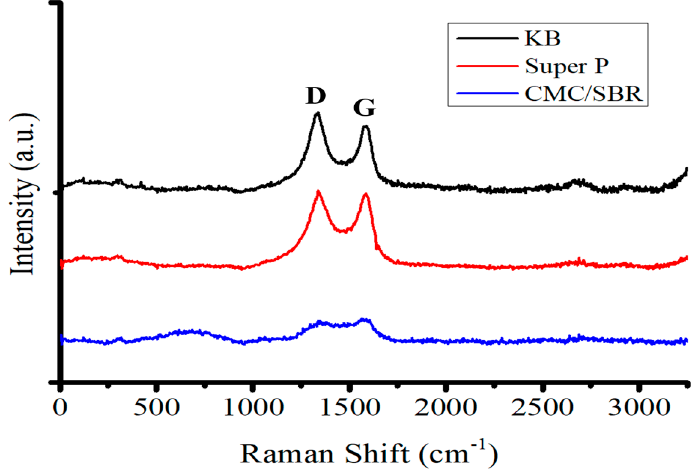
Figure 2. Raman spectra of carbon blacks of KB, Super P, and pyrolytic CMC/SBB. After pyrolysis of the CMC/SBR binders, the I D /I G ratio was approximately 0.94 . A wide, amorphous, carbon characteristic peak was situated between wavenumbers 500 and 1000 cm − 1 . An ordered/amorphous carbon porous carbon structure was formed post-py- rolysis.